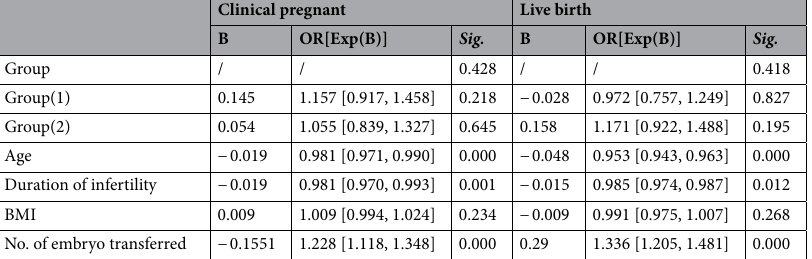
Table 6. Logistic model for clinical pregnancy and live birth after